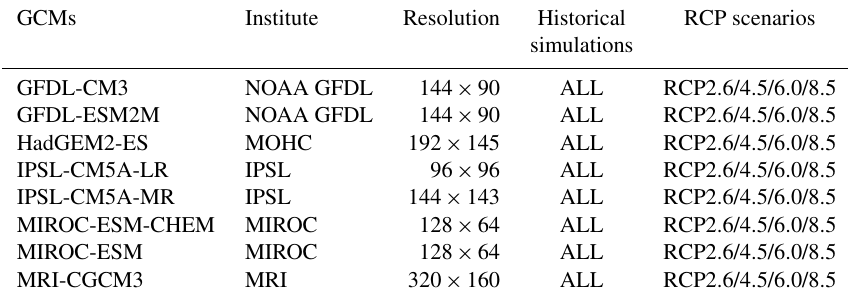
Table 1. CMIP5 model simulations used in this study. ALL represents historical simulations with both anthropogenic and natural forcings (r1i1p1 realization), RCP2.6/4.5/6.0/8.5 represent four representative concentration pathways from lower to higher emission